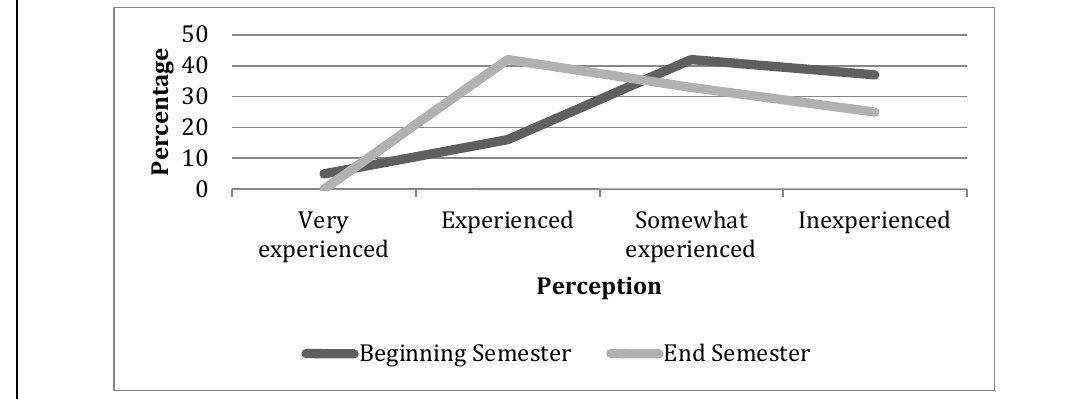
Figure 2: Student perceptions as online